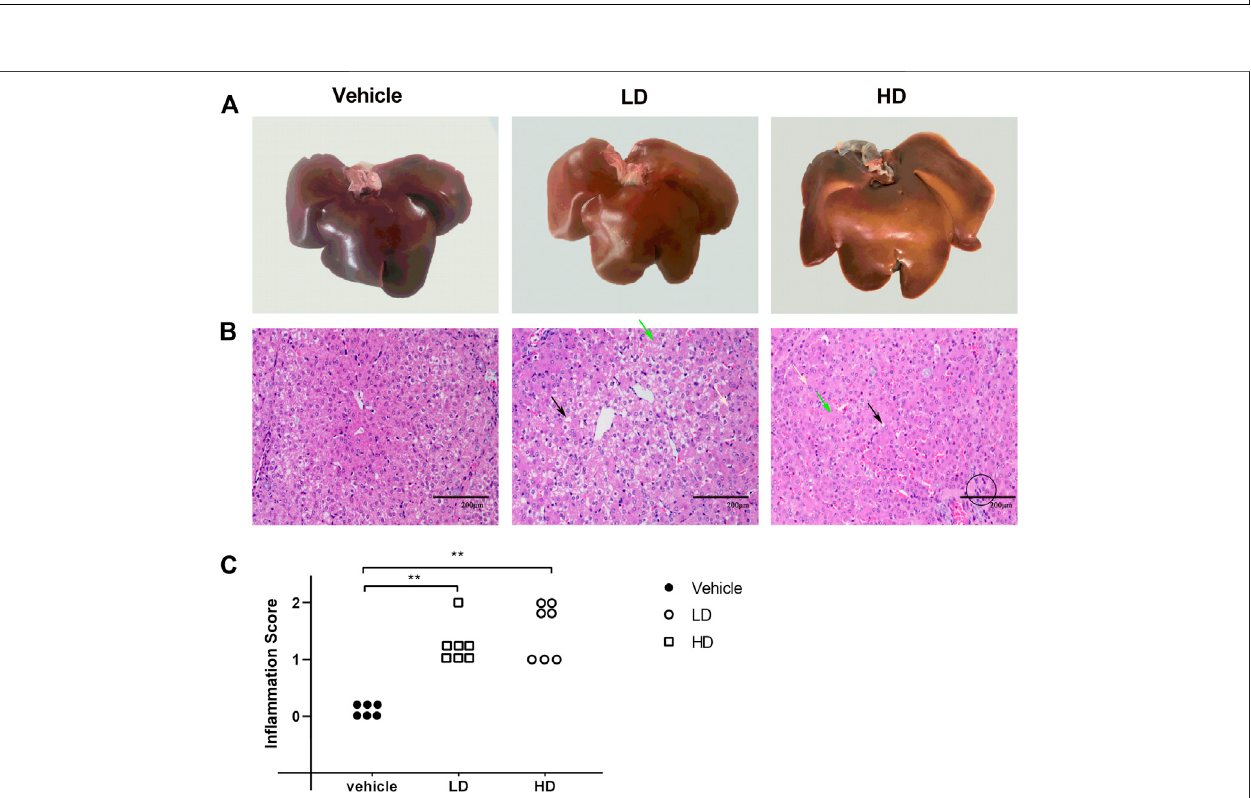
FIGURE 3 | TM-induced ERS causes liver injury in piglets. Piglets were administered with TM LD (0.1 mg/kg body weight), HD (0.3 mg/kg body weight), or vehicle for 48 h. (A) Liver morphology in different groups. (B) H&E staining of liver tissues in different groups. The black arrow denotes lipid droplets in the liver, green arrow denotes hydropicdegenerationin hepatocytes,and yellow arrow denotes dual-core. Theblack circle denotes the accumulation ofin fl ammatory cells asthe lesion ofthe in fl ammation score. (C) In fl ammation score of hepatic lobules in different groups. * means p < 0.05; ** means p < 0.01.